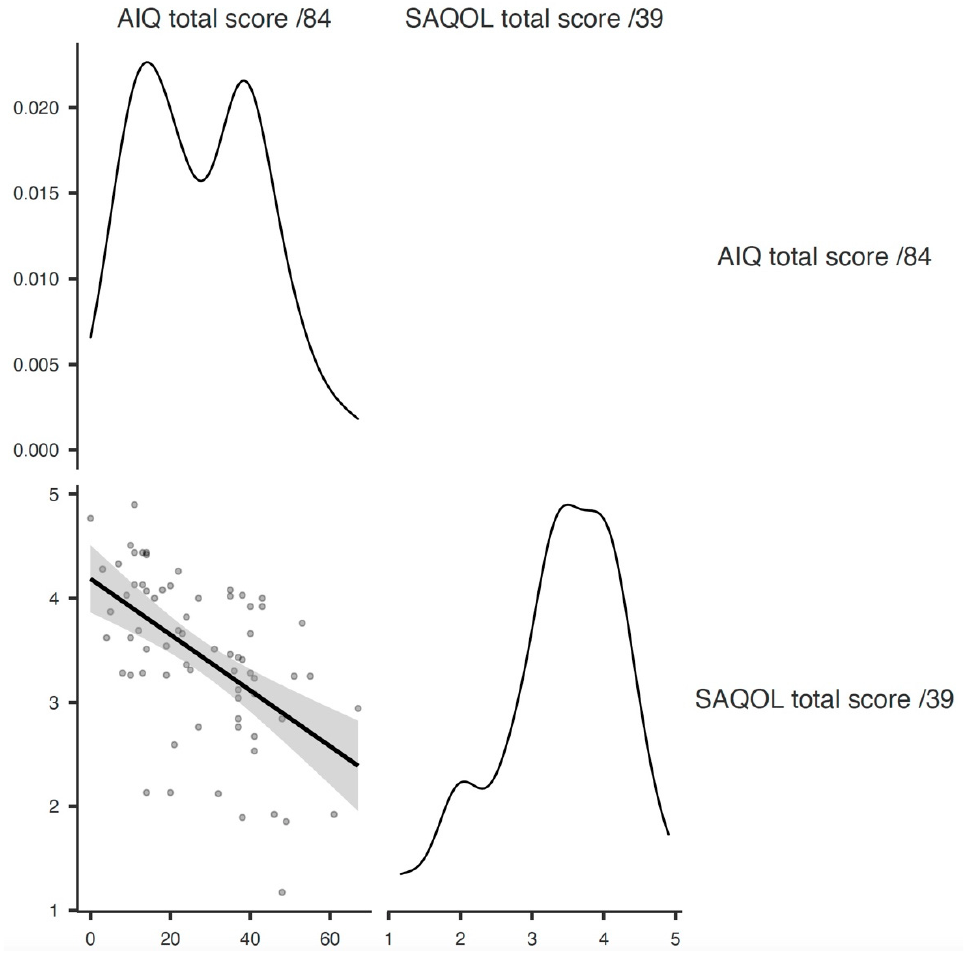
Figure 3. Correlation values comparing the total score on the AIQ-2-GR with the total score on the SAQOL-39.